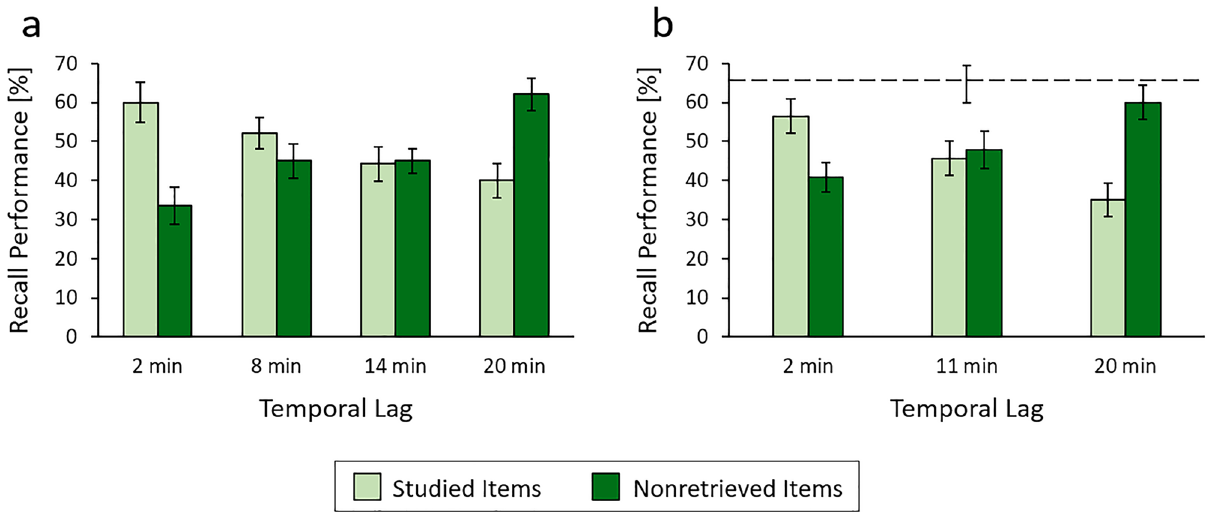
Figure 3. Results of experiment 1 ( a ) and experiment 2 ( b ). Recall of the studied items decreased but recall of the nonretrieved items increased from the shorter to the longer temporal lag conditions. After the short 2-min lag, recall of the studied items was superior to recall of the nonretrieved items; after the longer 20-min lag, the pattern reversed and recall of the nonretrieved items was superior to recall of the studied items; recall of the two item types was similar in the intermediate lag conditions. In experiment 2, recall of the nonretrieved items after the 20-min lag resembled recall of studied items when the studied items were tested immediately after study (indicated by the dashed line in ( b ). Error bars represent ± 1